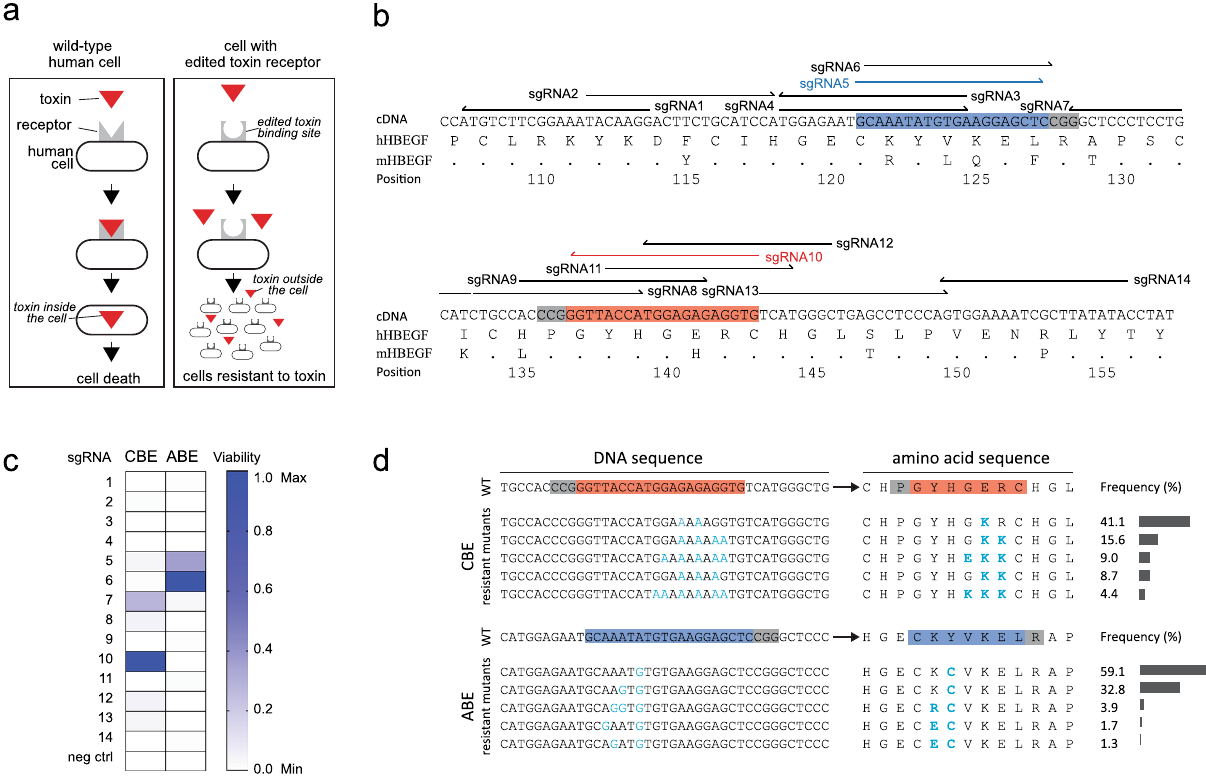
Fig. 1 Base editing at the HBEGF locus induces resistance to diphtheria toxin. a Schematic of our toxin-based selection scheme. b sgRNA sites targeted by CBE3 or ABE7.10, and used to screen for mutations in HBEGF that elicit resistance to DT. cDNA is the DNA sequence of the EGF-like domain of human HBEGF; hHBEGF is the corresponding amino acid sequence; mHBEGF is the aligned amino acid sequence of the mouse HBEGF homolog. Matching amino acids in mHBEGF are shown by a dot; unmatched amino acids are annotated. sgRNAs highlighted in red and blue were chosen to introduce DT-resistant mutations with CBE3 and ABE7.10, respectively. c Heatmap presenting the viability of HEK293 cells after DT selection for the depicted combination of